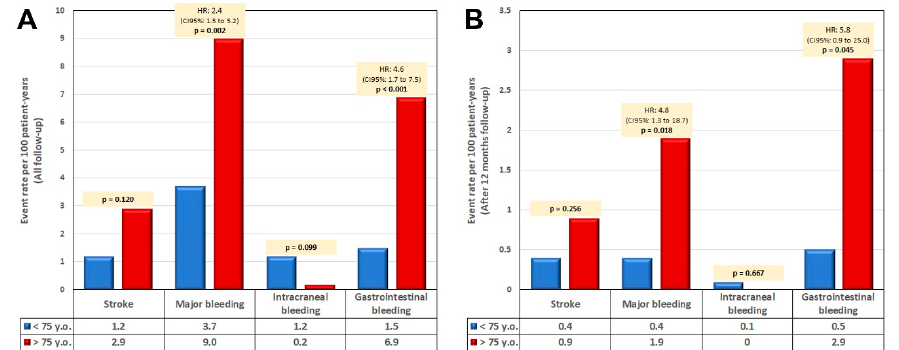
Figure 1. ( A ) Rate of events in patient-years according to age < or ≥ 75 years. ( B ) Rate of events in patients who completed the first year with no events. HR: hazard ratio; CI: confidence